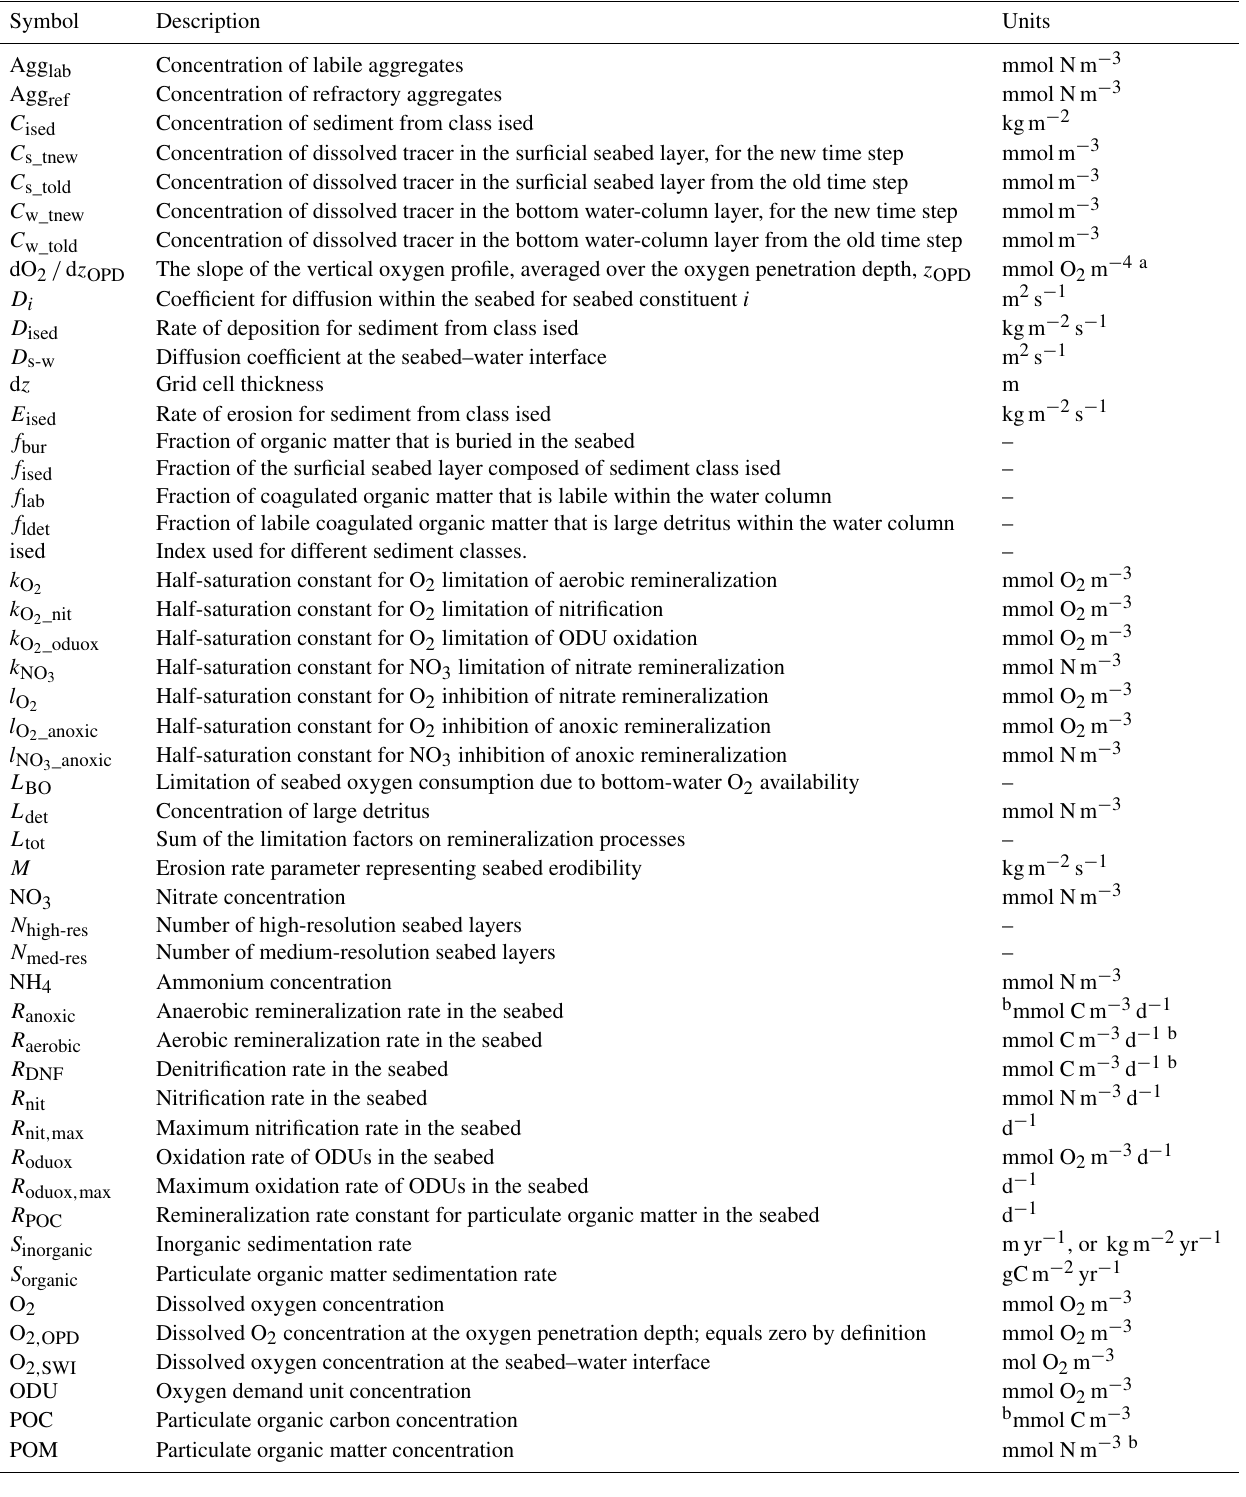
Table 1. Description of symbols used in this paper. Note that concentrations are porewater or bottom-water concentrations, not bulk concen- trations, unless otherwise noted, but units of length and area (i.e., meters, m, and meters squared, m 2 ) refer to the dimensions of the grid cell, and were not corrected for